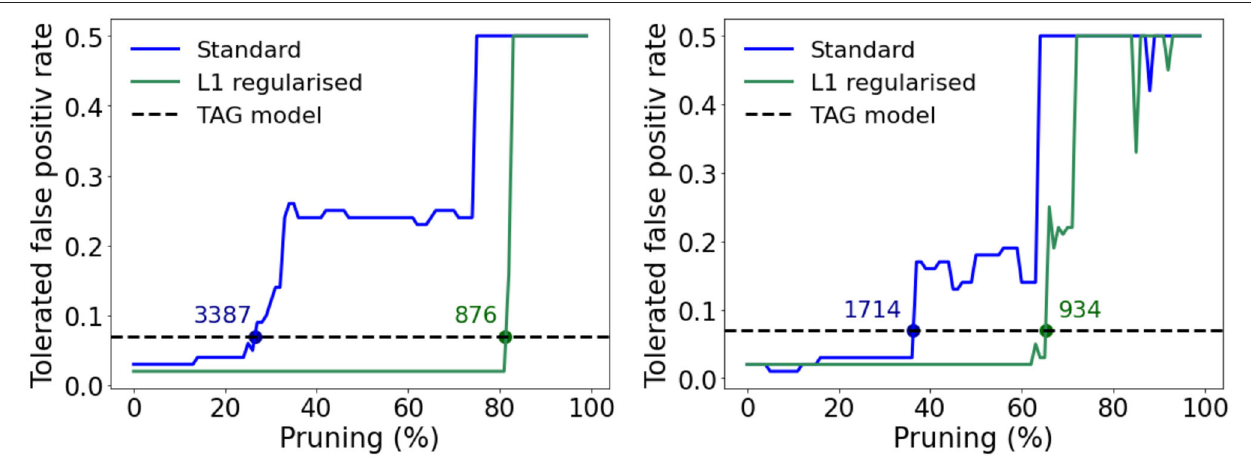
FIGURE 9 | Relationship between the tolerated false positive rate and the percentage of the weights closest to zero pruned for the standard (blue) and L 1 -norm regularized (green) models. The horizontal dashed line shows the tolerated false positive rate achieved by the TAG model. The number associated to each dot, drawn when the relationship crosses the horizontal dashed line, denote how many parameters the model required to match the tolerated FRP for the TAG model. (A) For the case of a single hidden layer MLP with 256 neurons in the hidden layer. (B) For the case of a three hidden layer MLP with 32 neurons per hidden